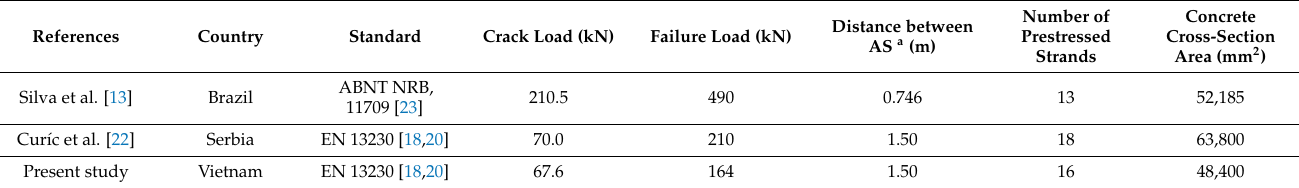
Table 6. Comparison of results of the present study and previous